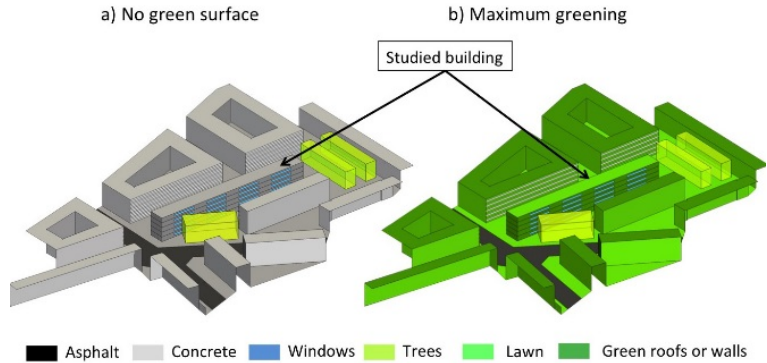
Figure 6. 3D models of the simulated configurations for the two extreme cases: ( a ) with no green surfaces; and ( b ) maximum greening.